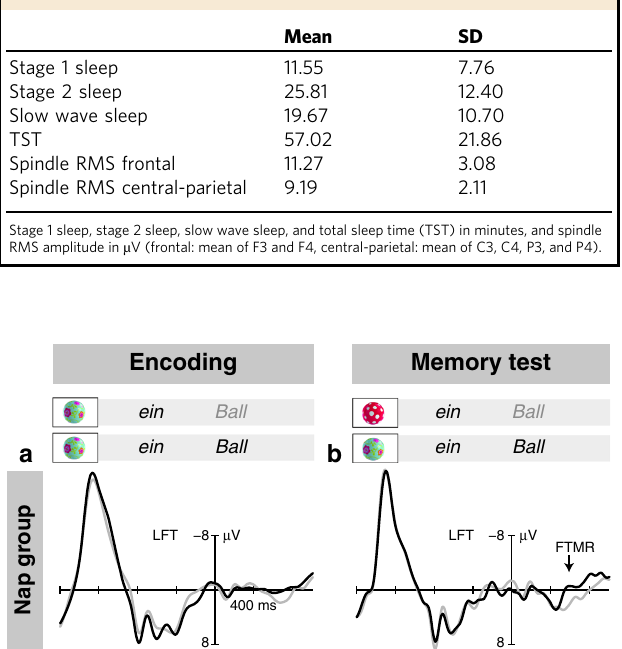
semantically correct object context (black lines) compared with the same words presented in a new semantically correct object context (grey